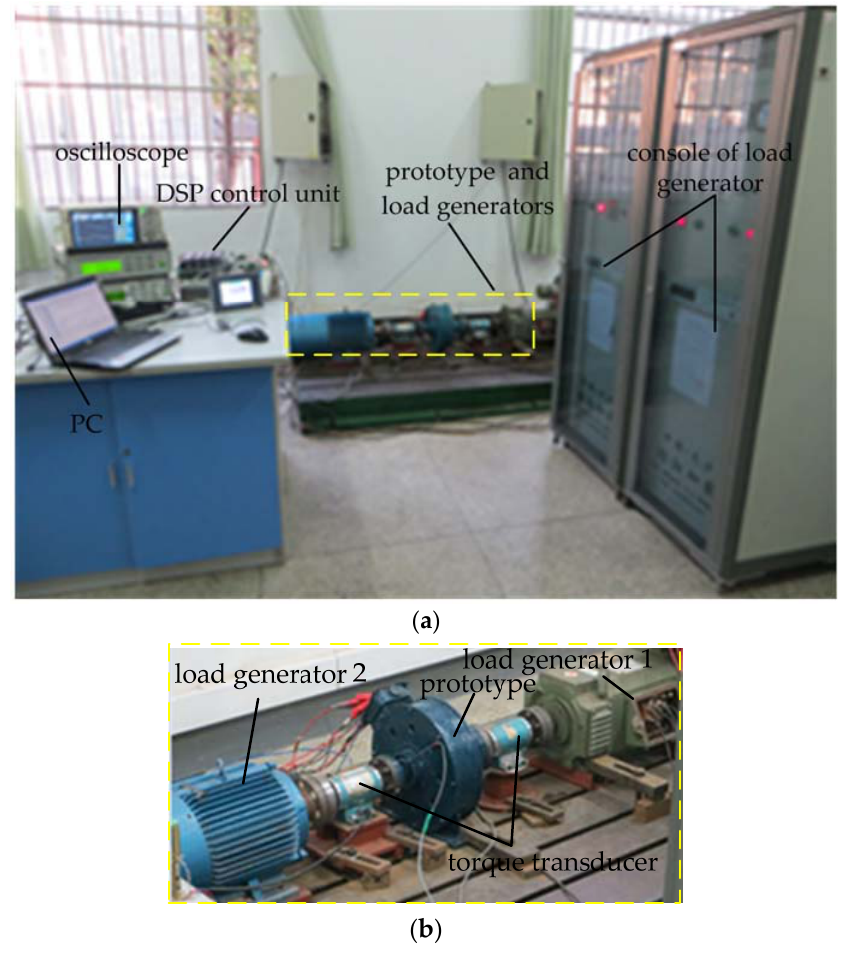
Figure 6. Photograph of the experimental platform. ( a ) Overview of the experimental set-up; and ( b ) overview of the prototype and the load generators.